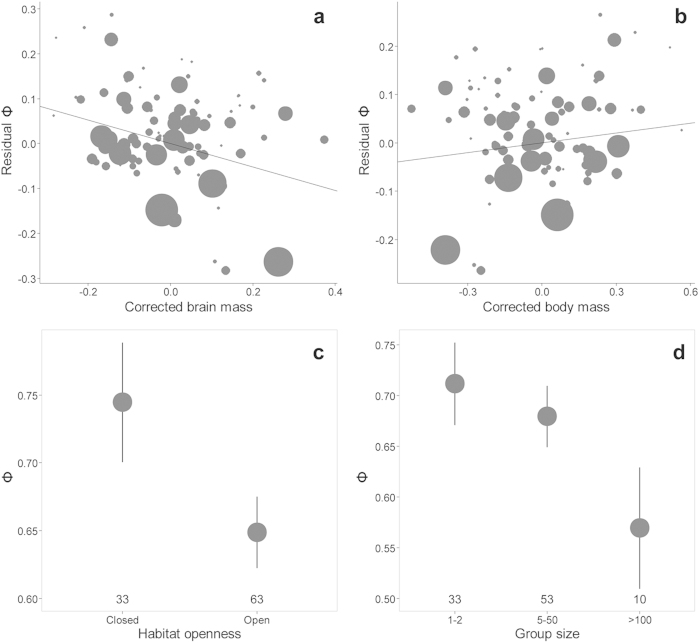
Effects of (a) brain mass, (b) body mass, (c) habitat openness, and (d) group size on interspecific escape strategy of birds.Escape strategy quantified by the phi index (Φ), an effect size metric that measures how immediately prey escape from predators upon detection. Larger Φ-values imply that prey escape at a distance close to the detection distance. Corrected (a) brain mass and corrected (b) body mass are residual values of these variables after controlling for their shared effect and different sizes of points reflect differences in a species’ sample size. Plots c and d show mean ± 95% confidence intervals; the number of species tested at each level is shown.